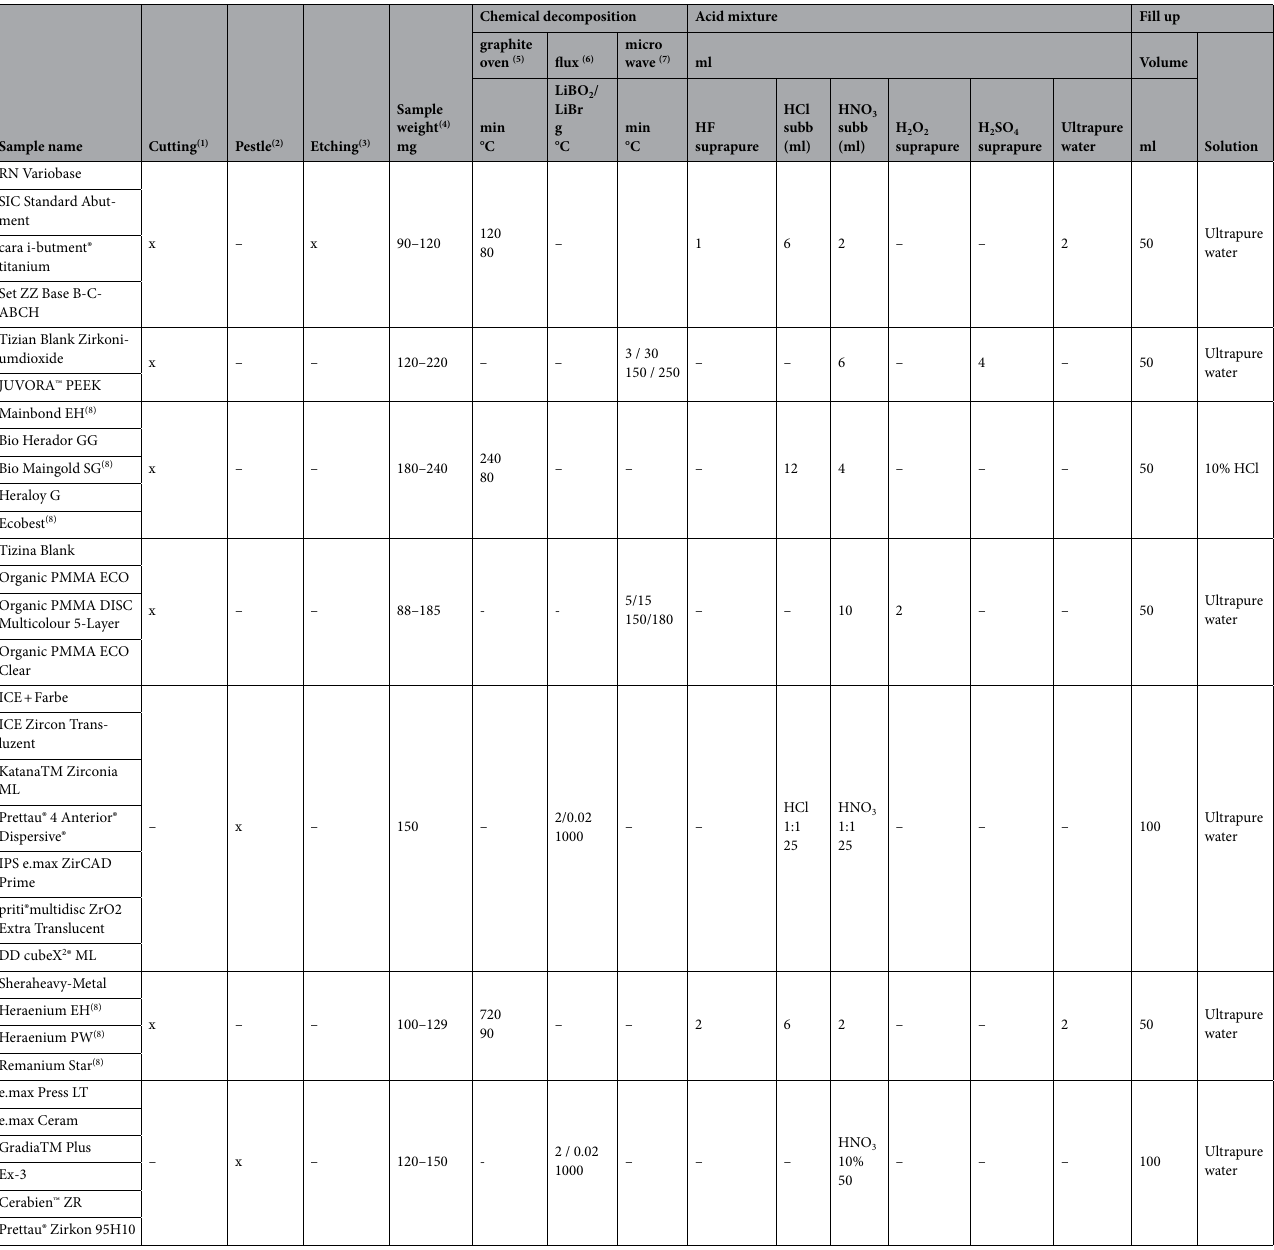
Al, Ti and V were below the respective detection limit. Therefore, a possible Be content was below the detection limit for all the evaluated samples.